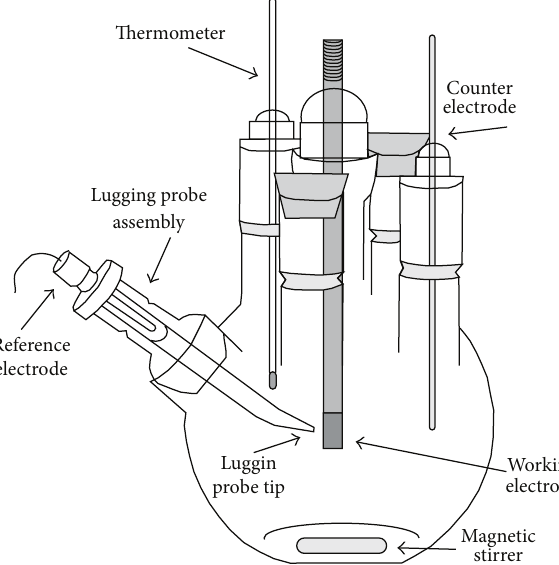
Figure 2: Experimental set-up for electrochemical measurements.